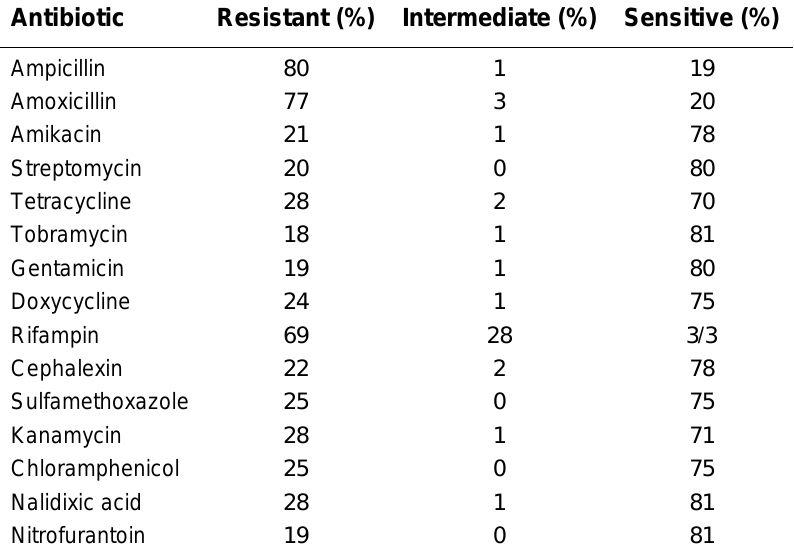
Prevalence of Antibiotic Resistance among Isolated Klebsiella